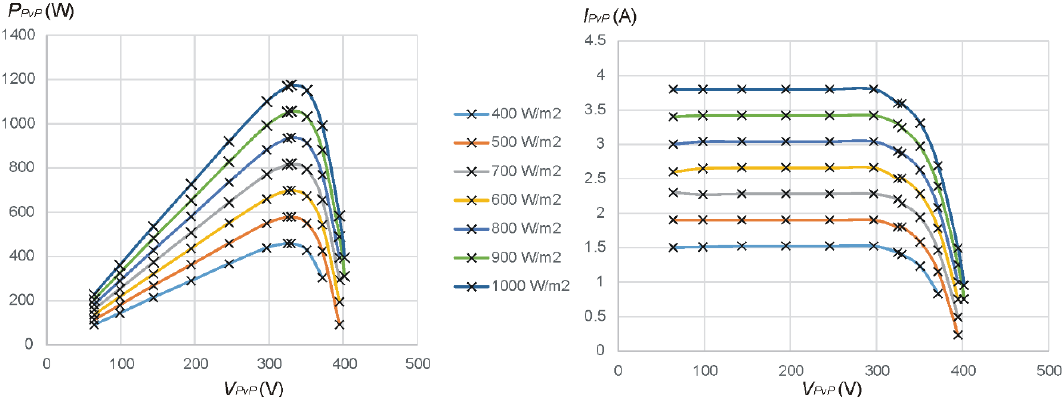
Figure 11. Emulated PvP P-V and I-V characteristics obtained from the laboratory experiment for assumed solar irradiances s in W / m 2 at temperature 298K.